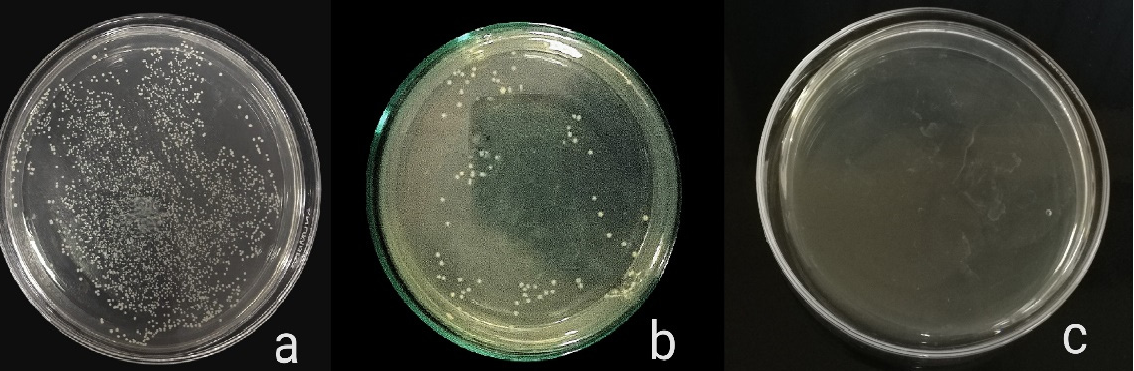
Figure 5. E. faecalis growth of unmodified composite discs ( a ), composite discs with 1% AgNPs ( b ), and composite discs with 1% CIP-AgNPs ( c ).